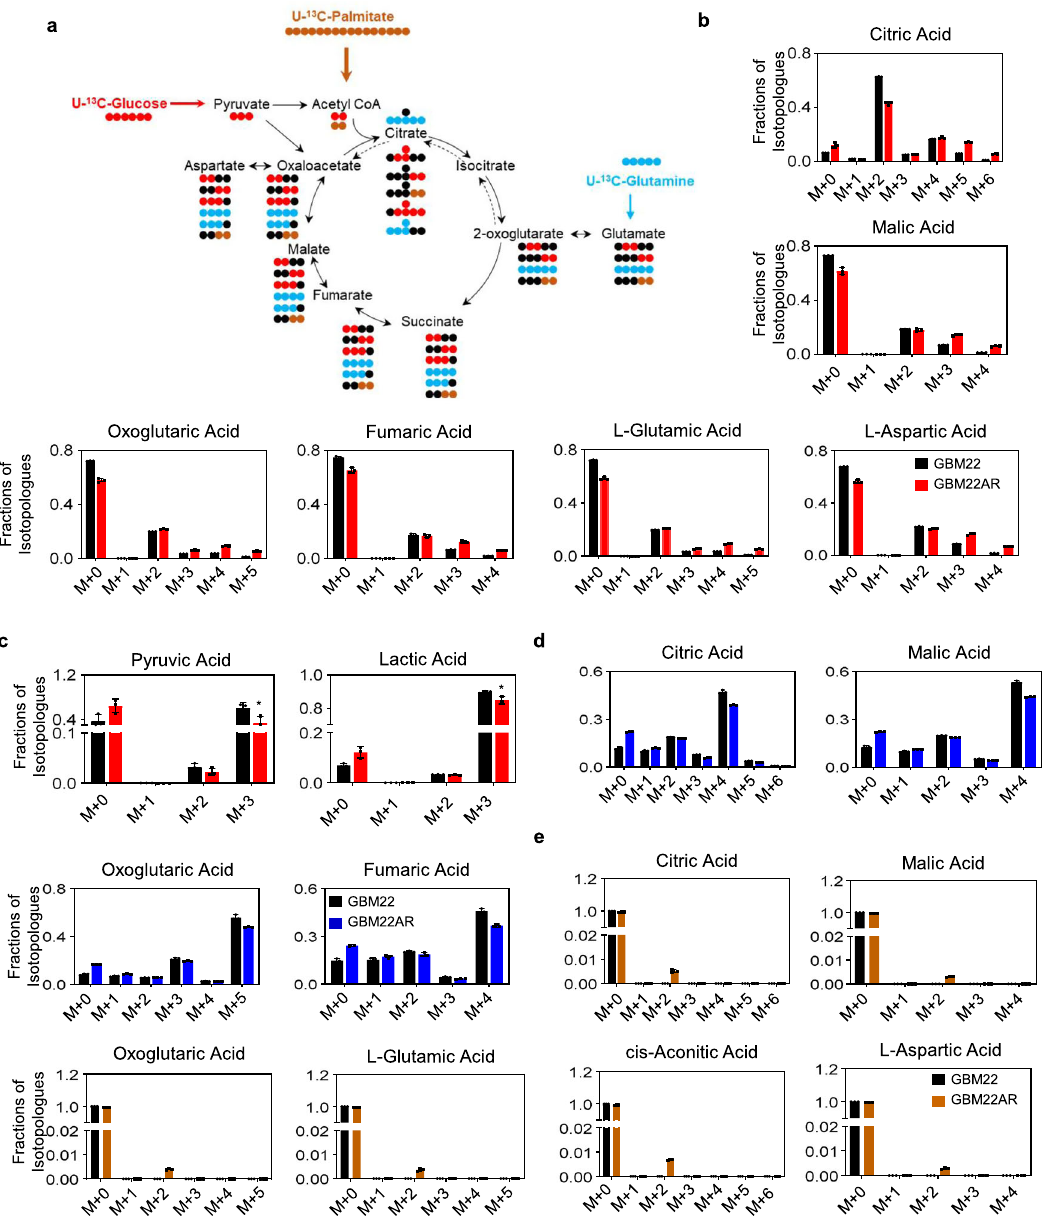
Fig. 5 AURKA inhibition impacts central carbon metabolism resulting in enhanced labeling of TCA cycle metabolites by long-chain fatty acids. a Summary of key reactions related to the tracer experiment. Blue circles indicate 13 C carbons from glutamine, brown circles indicate 13 C carbons from palmitic acid, whereas red circles highlight 13 C carbons from glucose. Black circles are used to display 12 C carbons. b , c Parental or chronically alisertib treated GBM22 cells were cultured in DMEM media containing 25 mM U- 13 C glucose, 4 mM glutamine and 10% dialyzed FBS and were subjected to LC/ MS analysis ( n = 3 independent samples) (pyruvic acid: * p = 0.0492, lactic acid: * p = 0.019). d Parental or chronically alisertib treated GBM22 cells were cultured in DMEM media containing 25 mM glucose, 4 mM U- 13 C glutamine and 10% dialyzed FBS and were subjected to LC/MS analysis ( n = 3 independent samples). e Parental or chronically alisertib treated GBM22 cells were cultured in DMEM media containing 5 mM glucose, 1 mM glutamine, 100 µ M U- 13 C palmitic acid, and 10% dialyzed FBS and were subjected to LC/MS analysis. Shown are relative percentages of the isotopologues for each metabolite ( n = 3 independent samples). Data are shown as mean ± SD in ( b − e ). Source data are provided as a Source Data fi